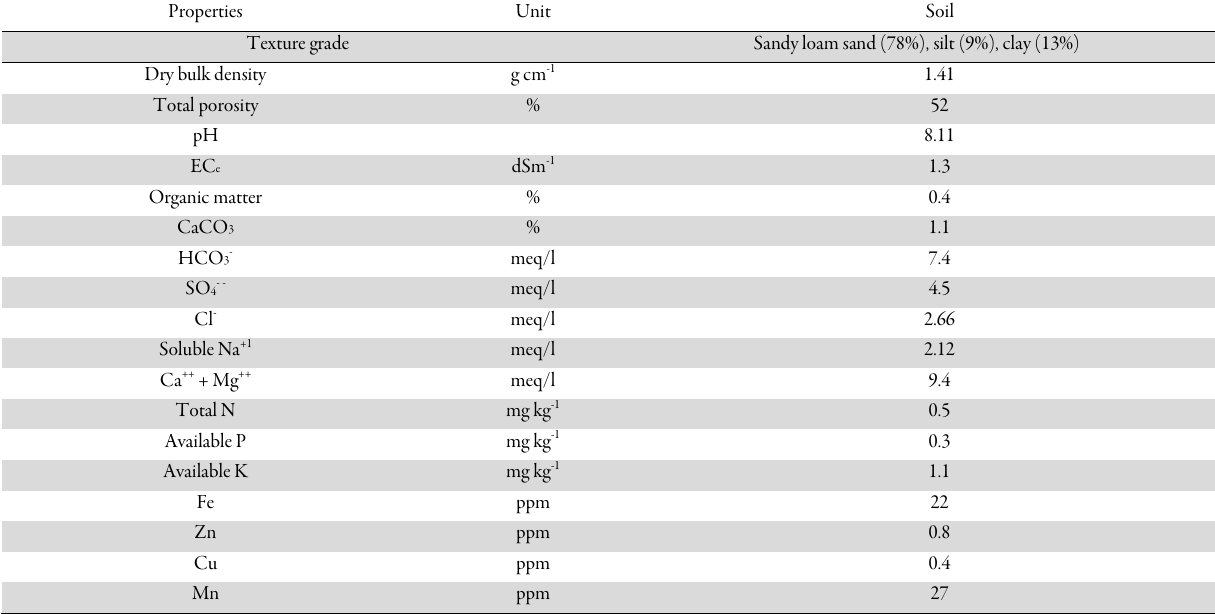
Table 1.The physico-chemical characteristics of the studied soil